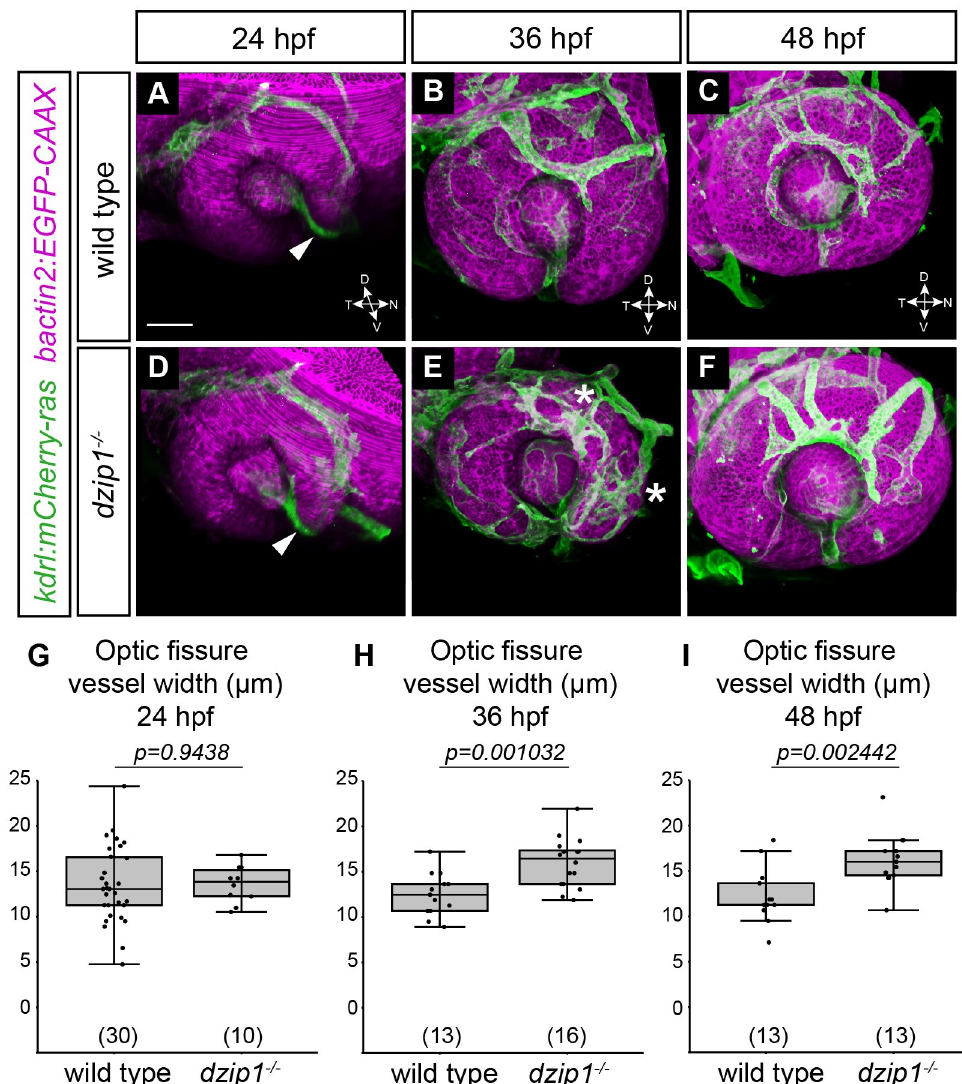
Fig 7. dzip1 mutants exhibit defective accumulation of POM-derived endothelial cells. (A-F) Embryos visualized for endothelial cells ( green ; Tg(kdrl : ras-mCherry) ) and cell membranes ( magenta ; Tg(bactin2 : EGFP-CAAX) ) in wild type (A-C) and dzip1 ts294e mutants (D-F) at 24 hpf (A, D), 36 hpf (B, E), and 48 hpf (C, F). All images are lateral views of 3-dimensional renderings. mCherry-positive endothelial cells populate the optic fissure by 24 hpf in both wild type and dzip1 -/- embryos (A, D; white arrowheads ). (E) asterisks , ectopic branching of the superficial network in dzip1 mutant. (G-I) Quantification of fissure vessel width (in μ m) at 24 hpf, 36 hpf, and 48 hpf. n (embryos) for each genotype shown at the base of the graph. P -values were calculated using Welch’s t-test (M-O). Scale bar: 50 μ m. D, dorsal; V, ventral; N, nasal; T, temporal. 7E and 7F), and quantification demonstrated that the hyaloid vessel remained wider in mutants compared to wild type siblings (Fig 7I; wild type siblings 12.27 ± 3.01 μ m; dzip1 mutants 16.04 ± 2.93 μ m). Separate from the optic fissure, in some dzip1 mutants, there appeared to be some aberrations in the superficial ocular vasculature, including some ectopic branches compared to wild type siblings (Fig 7B and 7E, asterisks ). Specifically, at 48 hpf, wild type embryos typically have two (occasionally three) dorsal branches: in our datasets, 10/13 siblings had two dorsal branches, while 3/13 had three. In contrast, all 13/13 dzip1 mutants